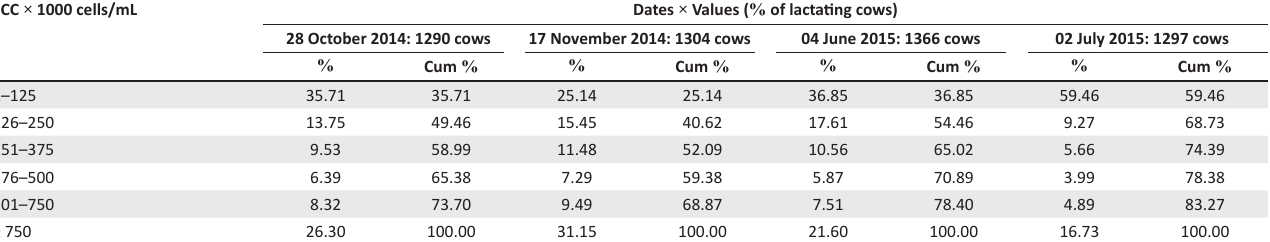
TABLE 2: Serial Herd Udder Health Report. Part 2: Somatic cell count history report for four consecutive herd examinations of the same herd based on the results of composite cow milk samples. SCC × 1000 cells/mL Dates × Values ( % of lactating